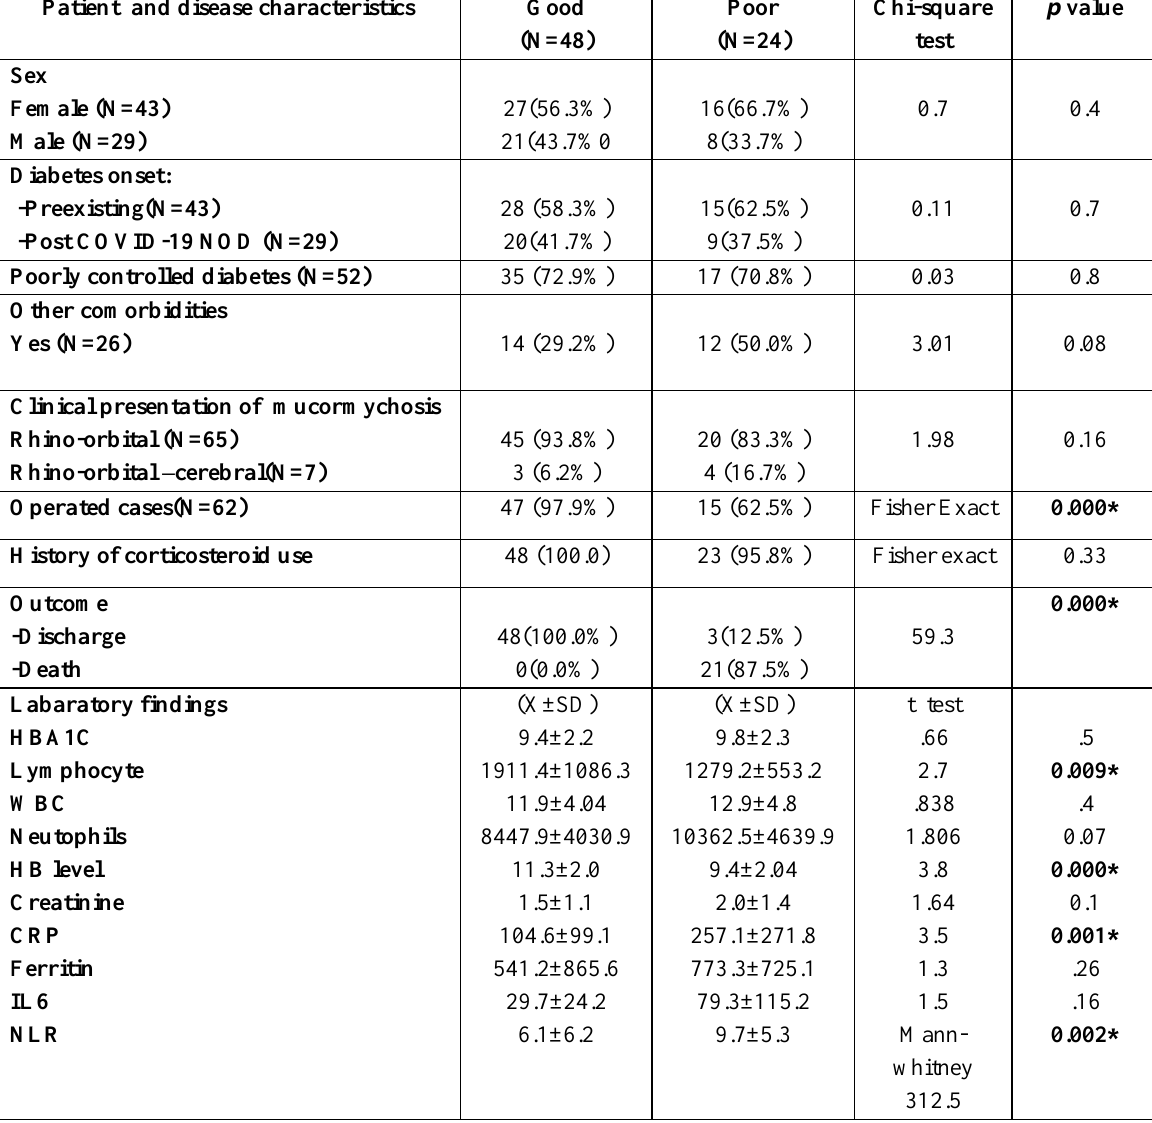
Table 2. Relation between patients and disease characteristics and prognosis of disease. Patient and disease